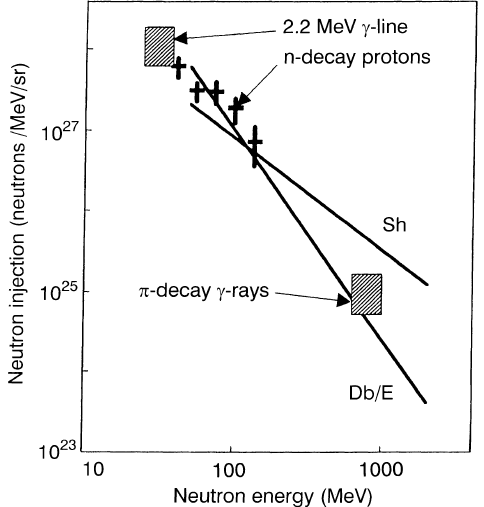
Fig. 6. Spectra of newly injected solar neutrons for the 3 June 1982 solar flare obtained using the IGY-D/ NM64-E (Db/ E) and IGY-Sh/ NM64-Sh (Sh) sensitivities in a comparison with neutron fluxes corresponding to observations of neutron-decay protons together with 2.2-MeV (cid:99) -line emission and pion decay